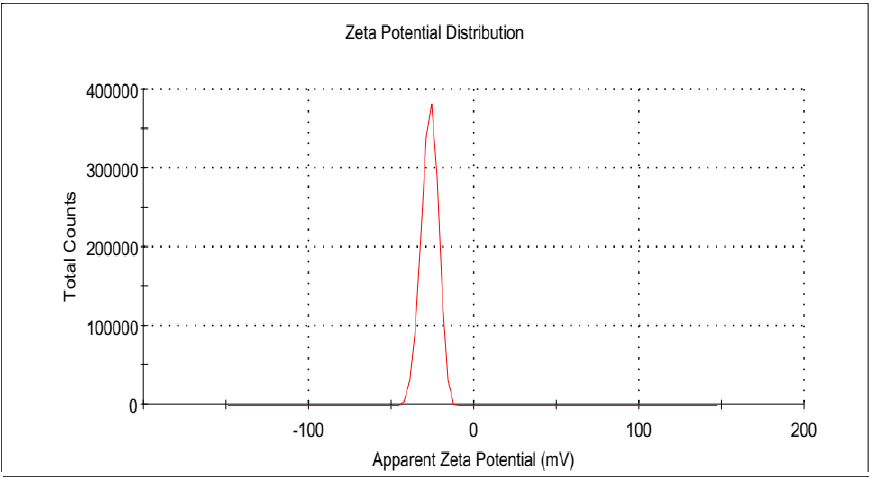
Figure 4. Zeta potential analysis of synthesized Er-ZnONPs.